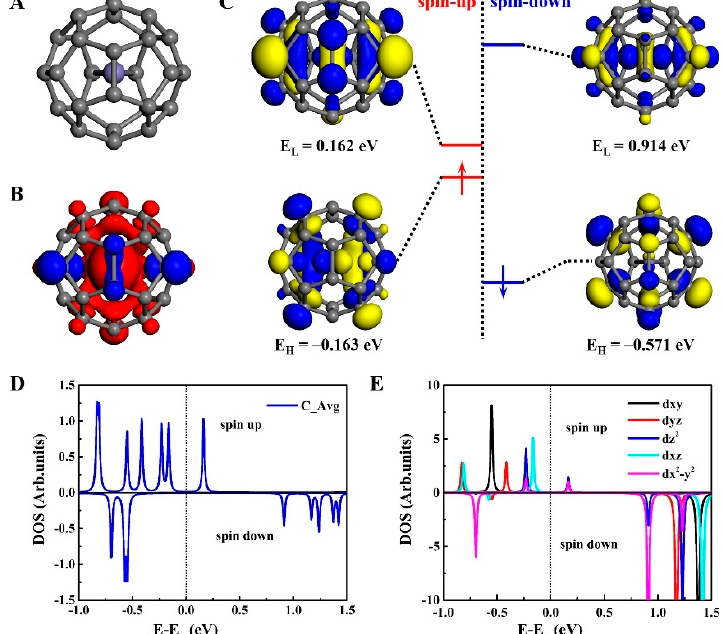
Figure 1. ( A ) Optimized structure of Fe@C 28 fullerene with C2v symmetry. There are 10 inequivalent C atoms, 13 inequivalent C–C bonds, and 6 inequivalent rings, with the inequivalent atoms labeled by di ff erent colors. ( B ) Spin density of Fe@C 28 . ( C ) Spin-resolved frontier orbitals of Fe@C 28 . Isovalue is set to ± 0.01 e / Å 3 . ( D ) Average spin-resolved density of states (DOS) projected to C28 of the Fe@C 28 with the energy window from − 1.0 to 1.5 eV. ( E ) Spin-resolved DOS projected to the five 3d orbitals of Fe atom.